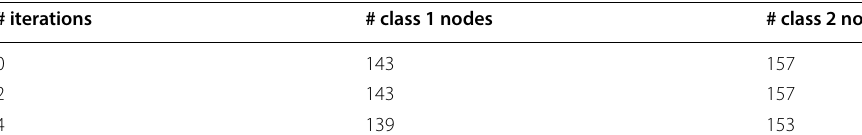
Table 2 Search space reduction